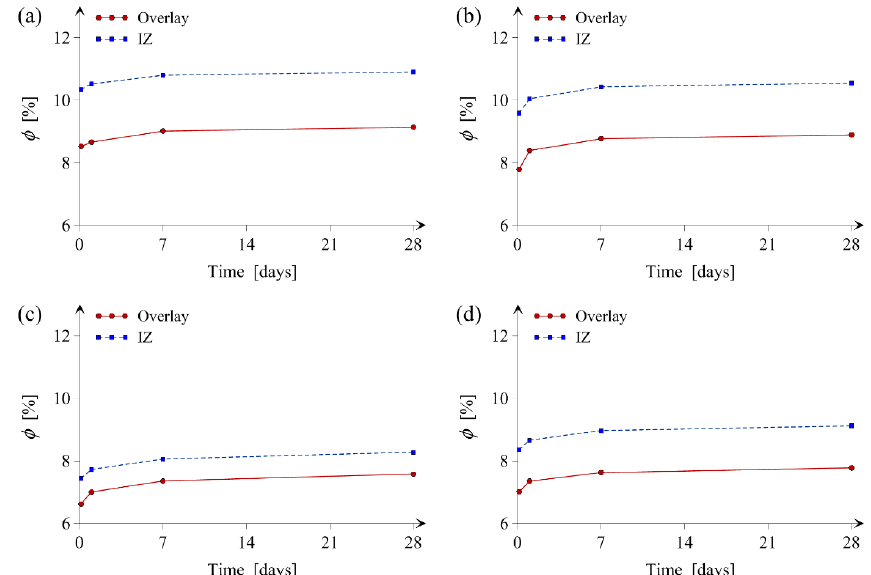
Figure 9. The average microporosity φ as a function along a sample height obtained within the IZ between the overlay and the existing concrete substrate obtained using the micro ‐ CT method at different moments of overlay hardening for Samples ( a ) T1; ( b ) T2; ( c ) T3; and ( d ) T4.